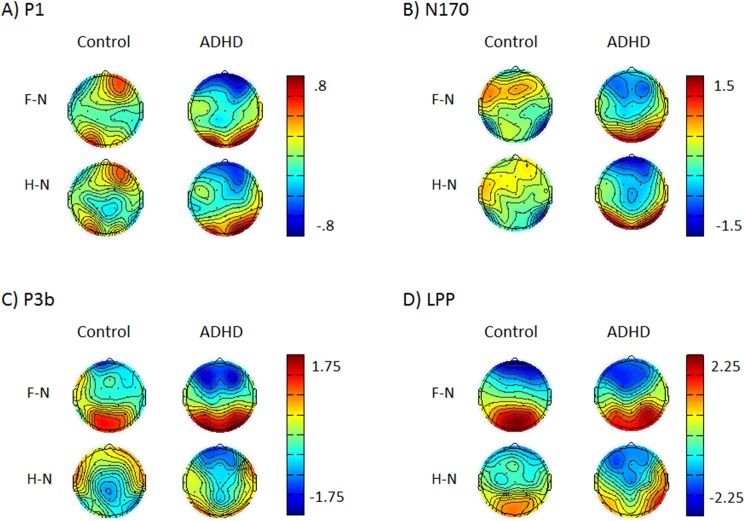
Topographic head plots of the fear-neutral (F-N) and happy-neutral (H-N) difference waves for the A) P1, B) N170, C) P3b, and D) LPP.